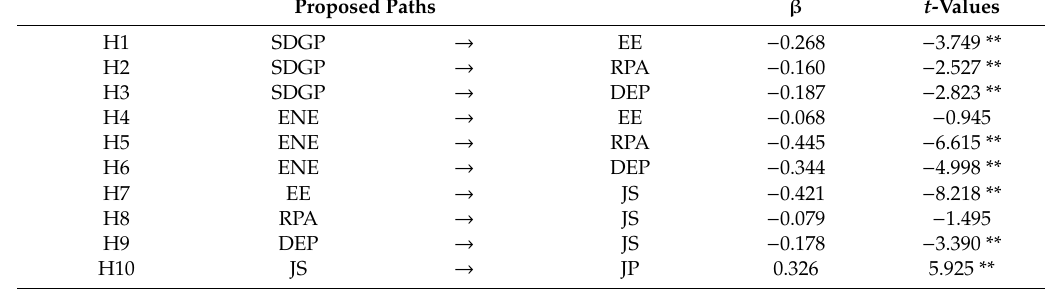
Total variance explained (R 2 ):